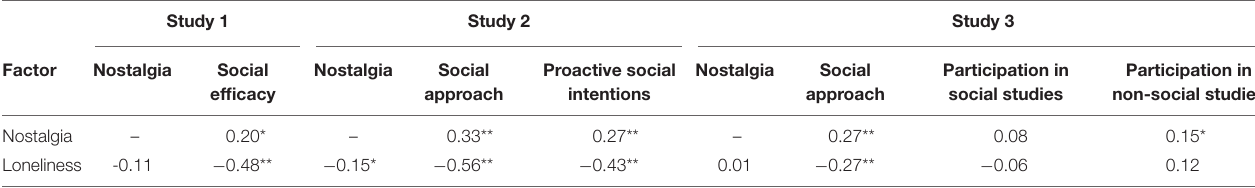
TABLE 1 | Bivariate correlations for Studies 1, 2, and